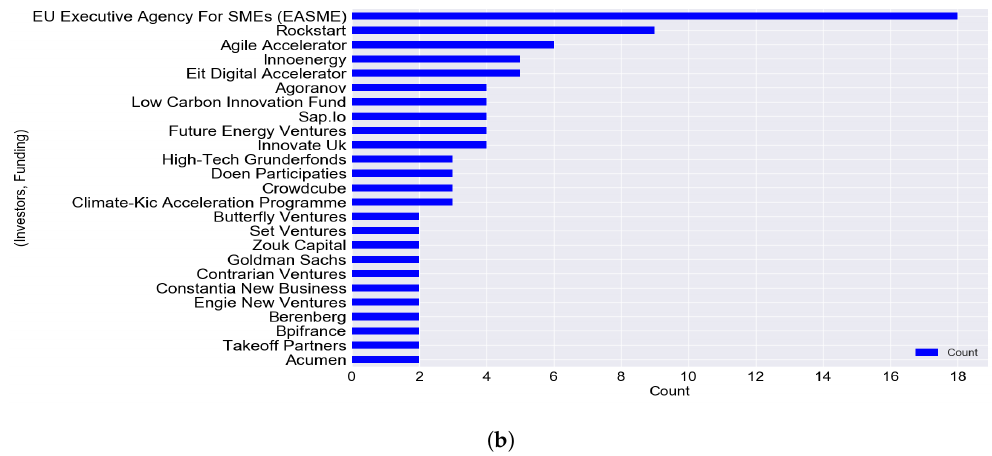
Figure 9. Inventors and funding for startups involved in Platforms, XaaS and Marketplace related services. ( a ) Investor count in different service categories ( b ) Top 25 investor and funding